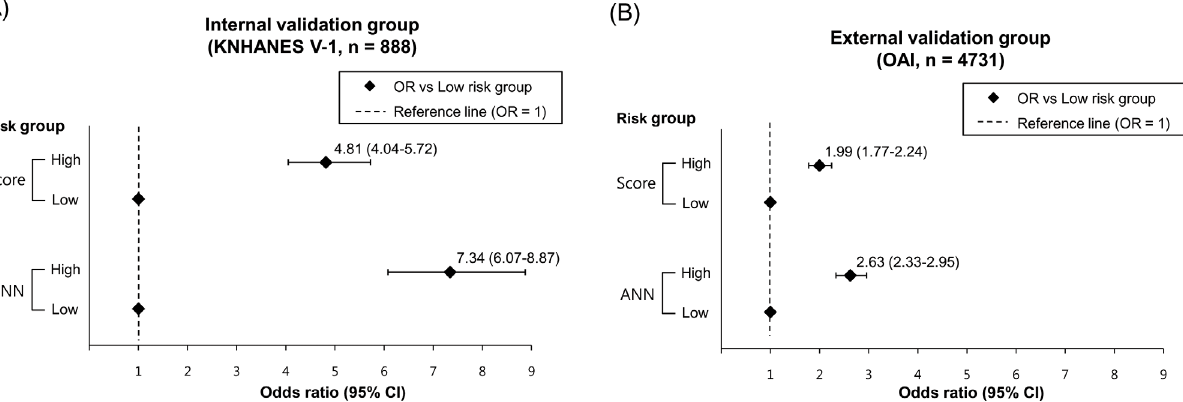
Fig 4. Odds ratios of radiographic knee osteoarthritis in the different risk groups. Comparison of odds ratios of high risk group indicated by the screening score and artificial neural network (A) in internal validation group (KNHANES 2010) and (B) external validation group (OAI). KNHANES, Korea National Health and Nutrition Examination Survey; OR, odds ratio; OAI, Osteoarthritis